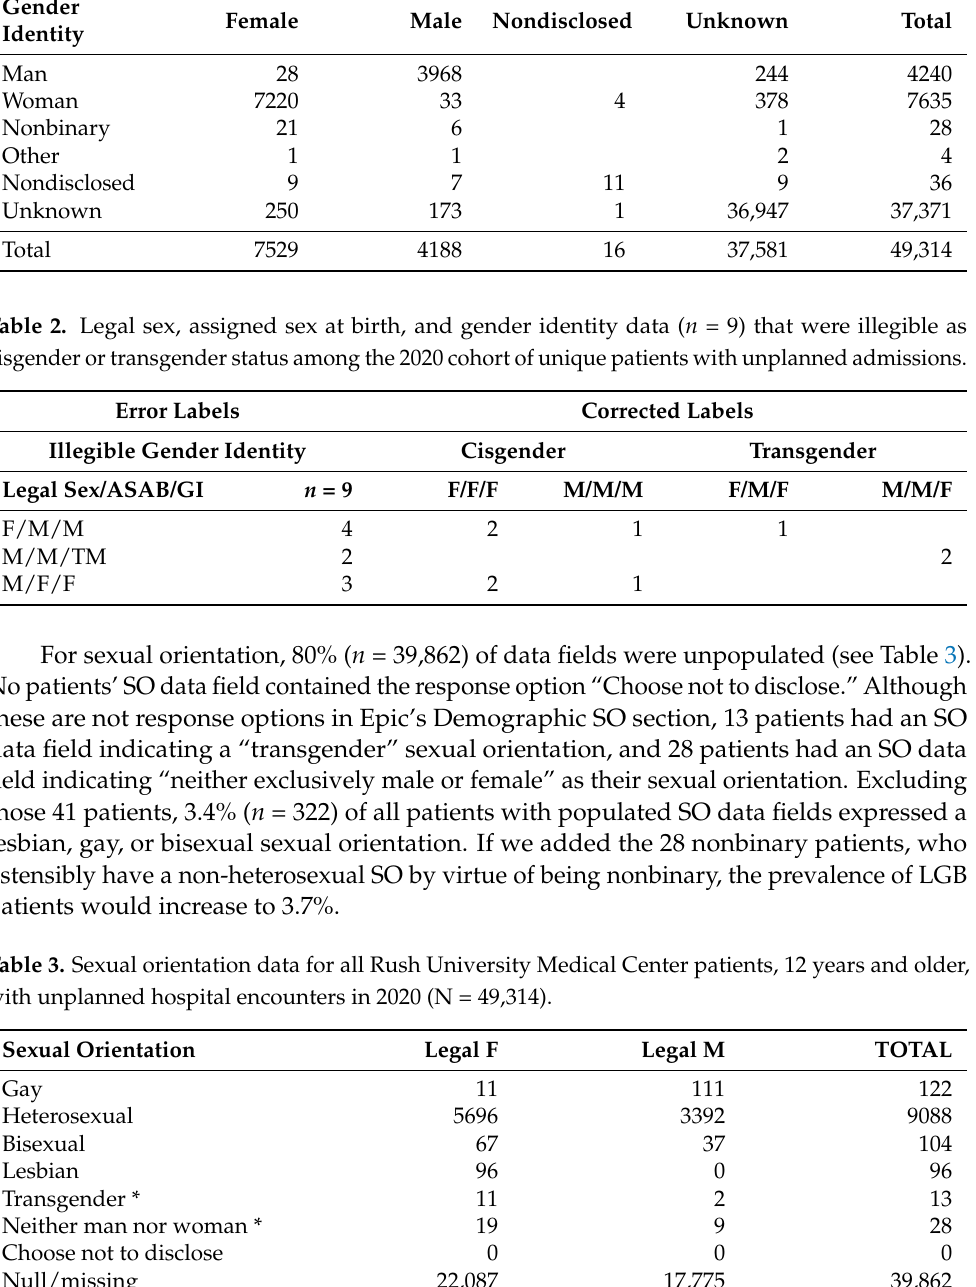
Neither man nor woman * Choose not to disclose